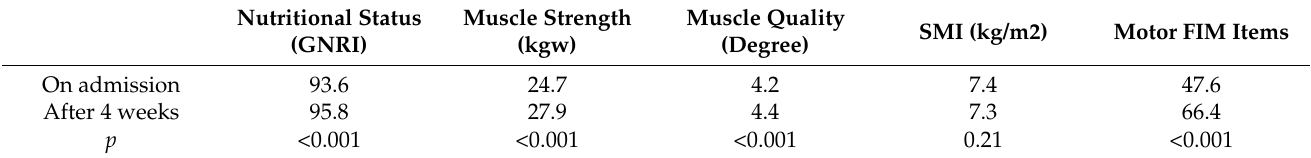
Table 3. Changes in nutritional status, muscle strength, quality, and SMI in male